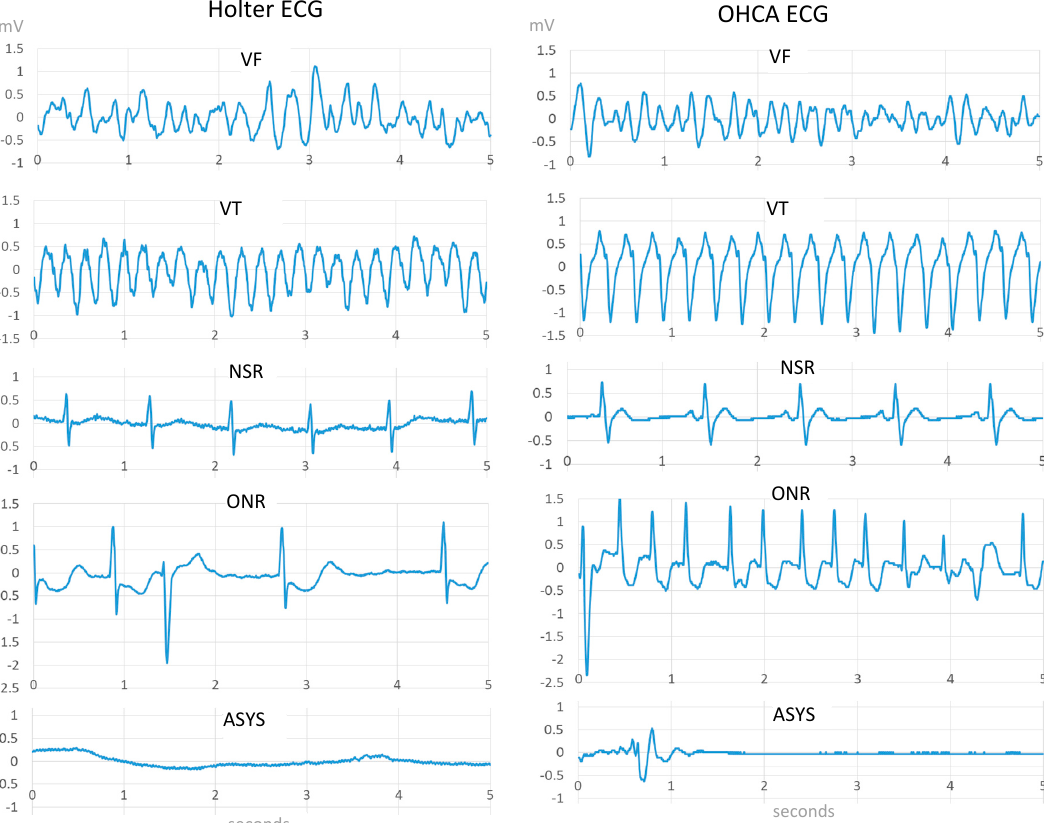
Figure 1. Examples of 5 s electrocardiogram (ECG) strips, extracted according to the defined annotation scheme for shockable (ventricular fibrillation—VF, rapid ventricular tachycardia—VT) and nonshockable (normal sinus rhythms—NSR, other nonshockable rhythms—ONR, asystole—ASYS) rhythms, found in Holter (left panel) and out-of-hospital cardiac arrests (OHCA) (right panel) databases.